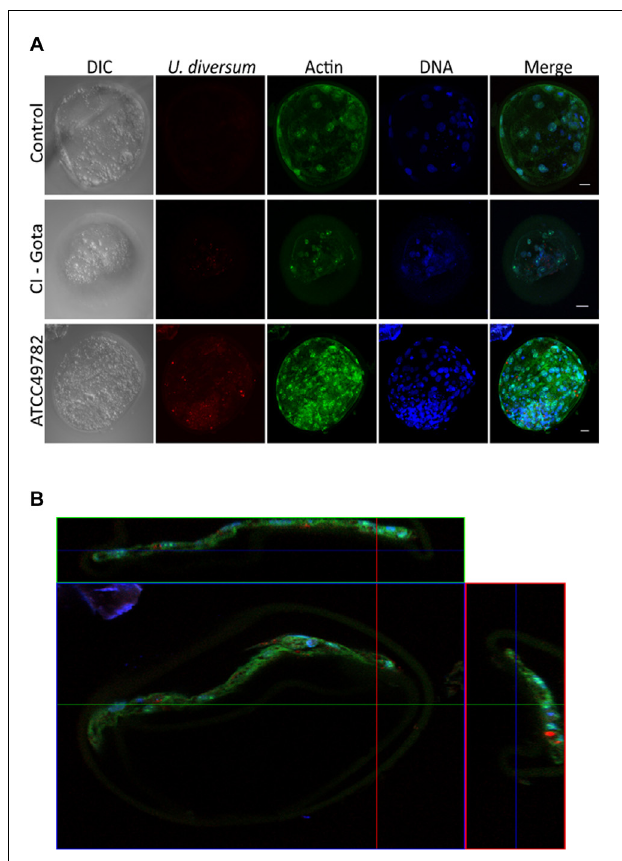
FIGURE 6 | (A) Confocal microscopy: internalization of U. diversum in bovine blastocysts after 24 h of infection. Scale bars: 20 µ m. Ureaplasmas in red (Vybrant Dil), actin in green (FITC) and DNA in blue (TOPRO-3). U. diversum was internalized as shown in the merged image. (B) Orthogonal projection of confocal microscopy showing the internalization of U. diversum ATCC49782 in bovine blastocysts after 24 h of infection. Ureaplasmas visualized by Vybrant Dil (red), actin by FITC (green) and DNA by TOPRO-3 (blue). U. diversum was internalized as shown in the merged